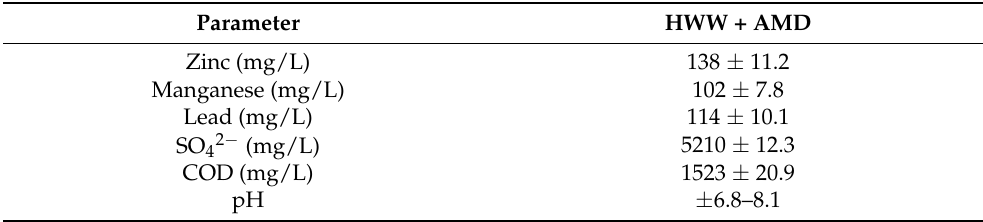
Table 2. Measurements of acid mine drainage (AMD) and hospital wastewater (HWW) at the mixing point of 2:5 v/v . Parameter HWW + AMD Zinc (mg/L) 138 ± 11.2 Manganese (mg/L) 102 ± 7.8 Lead (mg/L) 114 ± 10.1 SO 42 − (mg/L) 5210 ± 12.3 COD (mg/L) 1523 ± 20.9